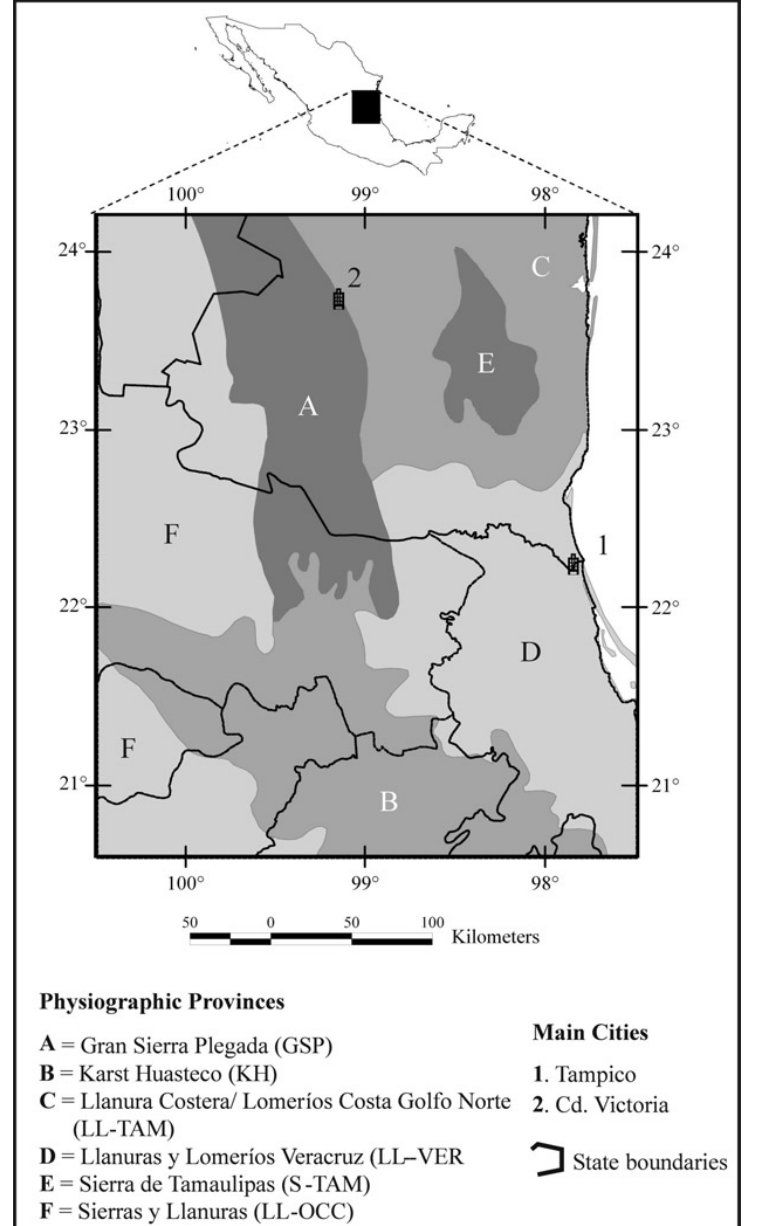
Fig. 1. Study area in northeastern Mexico, showing six physiographic provinces or subregions.The three subregions used for analyzing land ownership types consisted of (1) sierras ( Gran Sierra Plegada, KARST Huasteco, and Sierra de Tamaulipas, (2) Costa del Golfo ( Llanuras y Lomeríos de la Costa